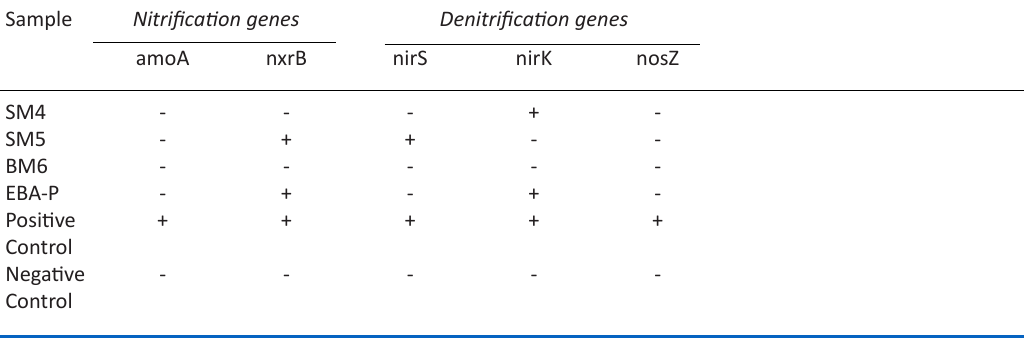
Table 4. Identification of specific genes related to nitrification and denitrification processes in the strains evaluated Sample